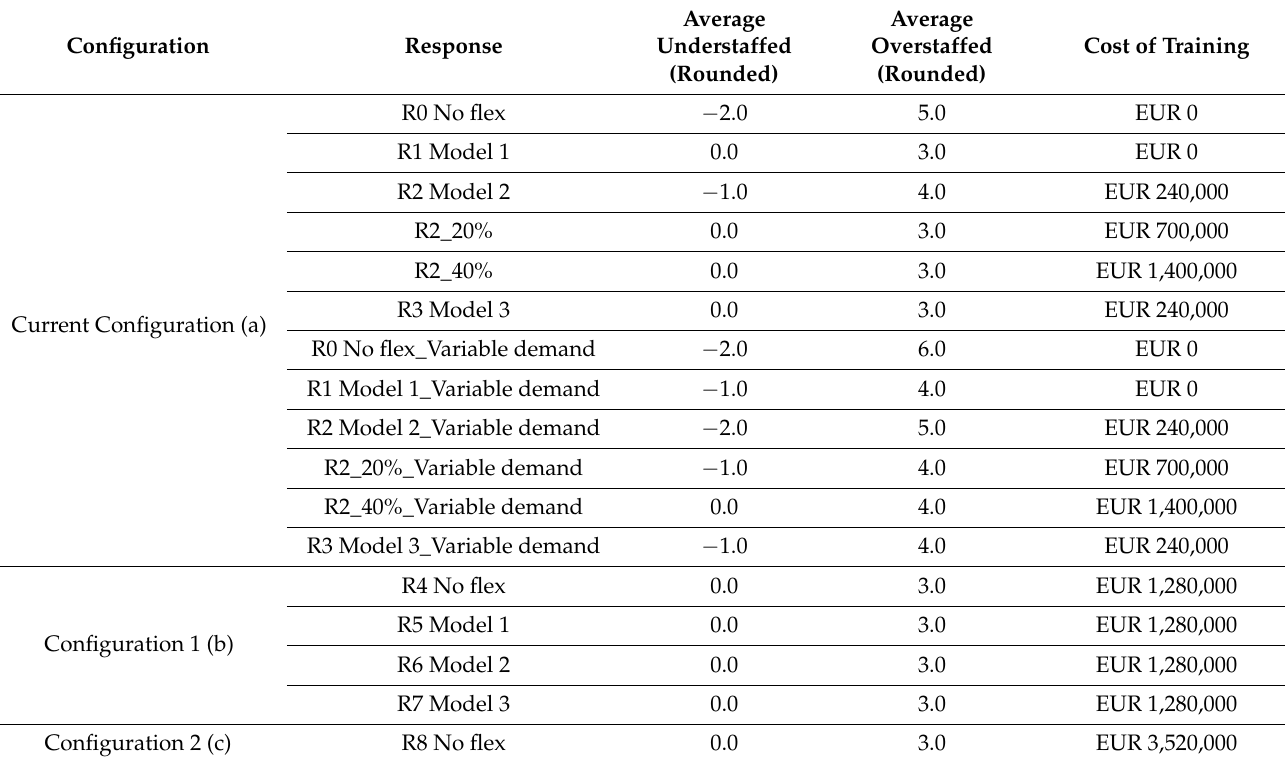
Table 9. Results for different